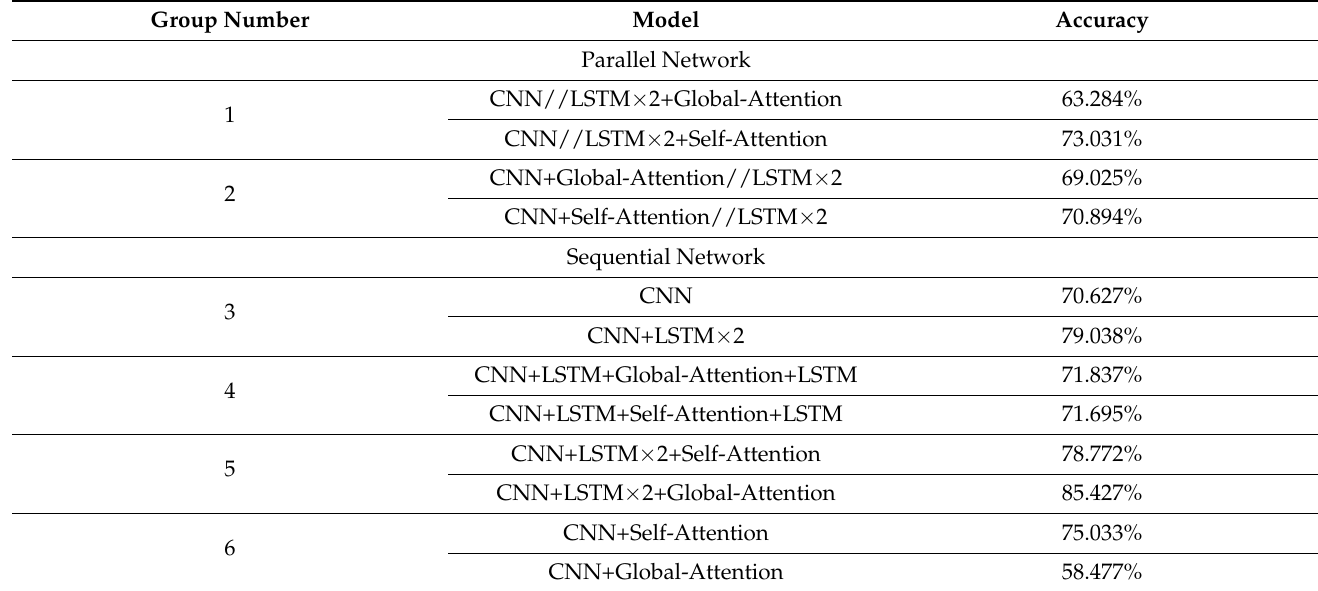
Table 3. The accuracy of the models set in this paper.